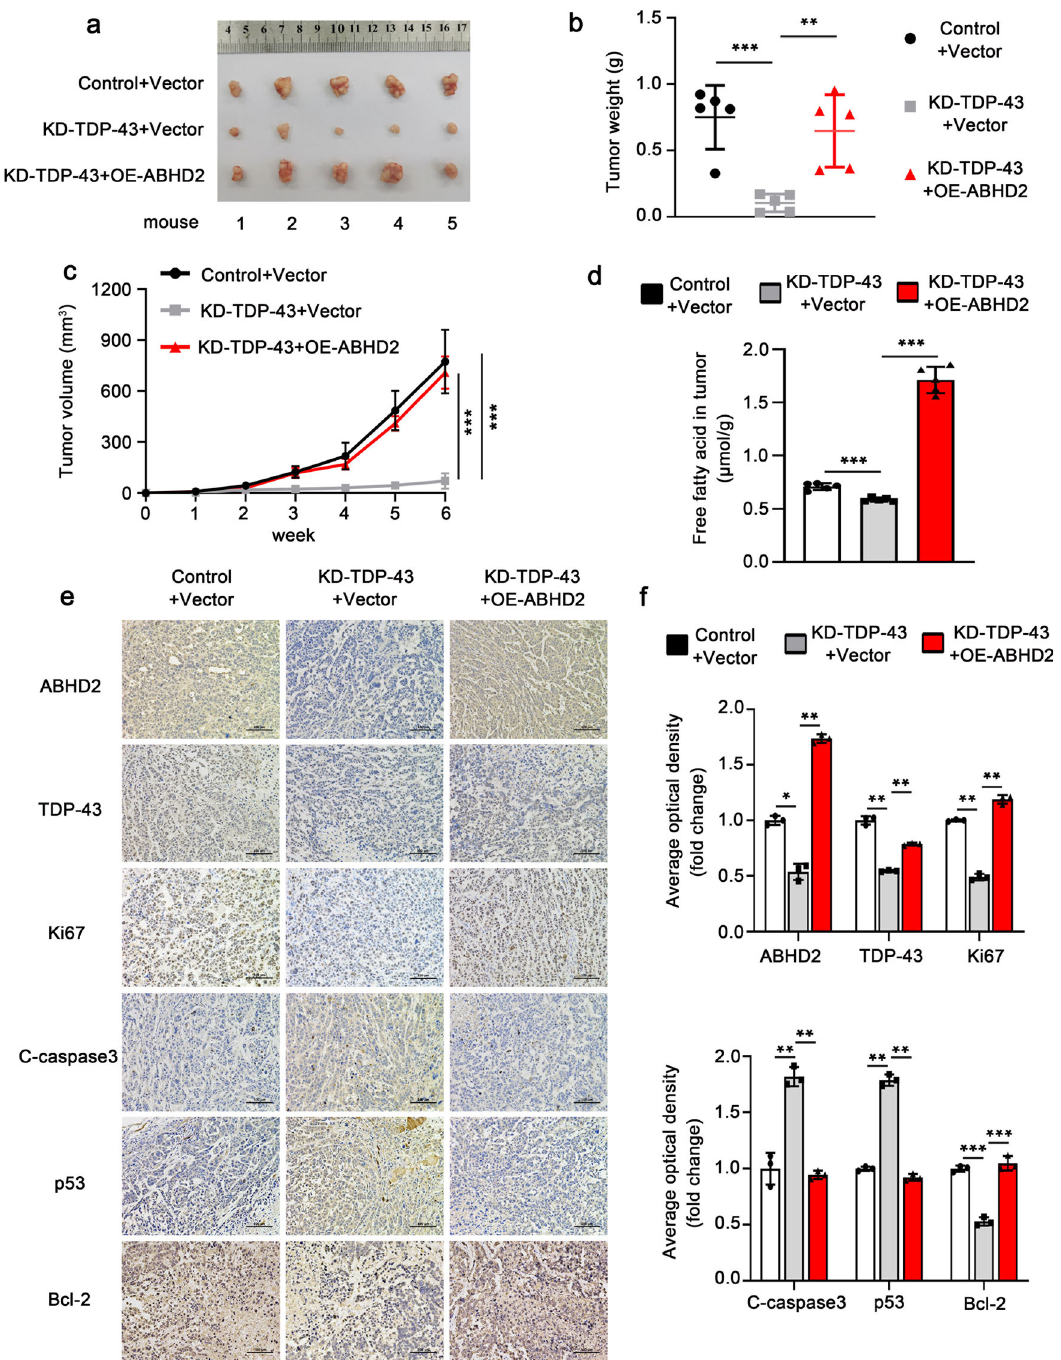
Fig. 8 TDP-43 facilitates lipid metabolism via ABHD2 to suppress apoptosis in vivo. Tumor images ( a ), tumor weights ( b ), and tumor growth curves ( c ) of the xenograft tumors derived from MHCC97H-Control + vector, MHCC97H-KD-TDP-43 + vector and MHCC97H-KD-TDP-43 + OE-ABHD2 cells ( n = 5). d Analysis of FFA levels in mice tumors of the indicated three groups. IHC staining of ABHD2, TDP-43, Ki67, C-caspase3, p53 and Bcl-2 in mice tumors ( e ) and quantitative analysis ( f ). Scale bar: 100 µ m. Error bars represent ± s. d. * P < 0.05, ** P < 0.01, *** P < 0.001 by two-tailed Student ’ s t